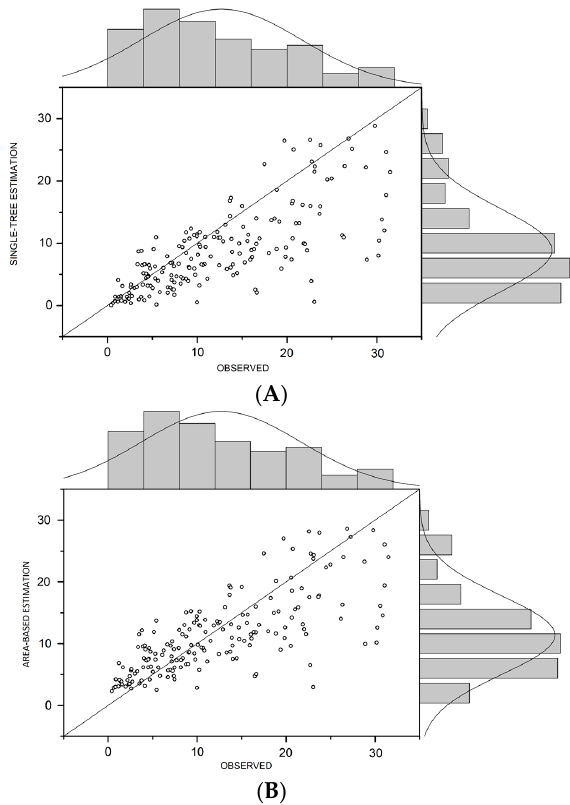
Figure 5. Accuracy of the AGB (in t·ha − 1 ) wall-to-wall spatial estimation based on the single-tree ( A ) and area-based ( B ) approach.